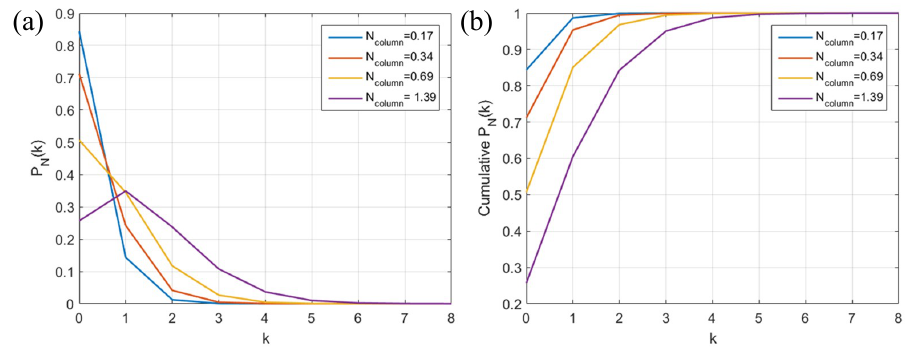
Figure 3. ( a ) Poisson distribution and ( b ) cumulative distribution of P N (k) at column activity of 0.17, 0.34, 0.69 and 1.39.